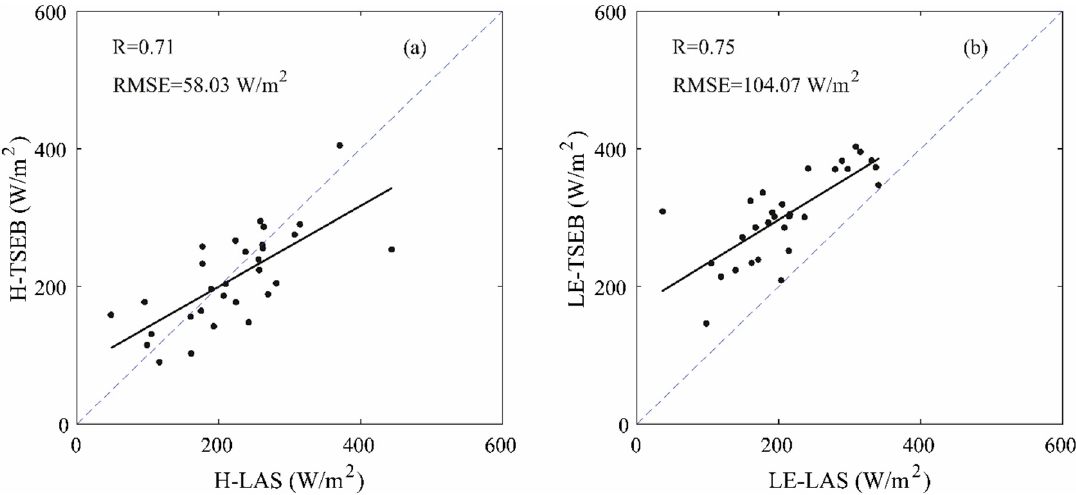
Figure 12. Scatterplots between TSEB predictions H ( a ) and LE ( b ) based on Landsat and LAS measurements using available energy driven by Landsat.